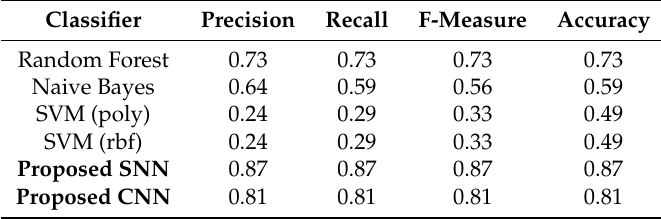
Table 5. Performance metrics for IMDb, where SVM (poly): Support Vector Machine using a polynomial kernel, SVM (rbf): Support Vector Machine using a radial basis function